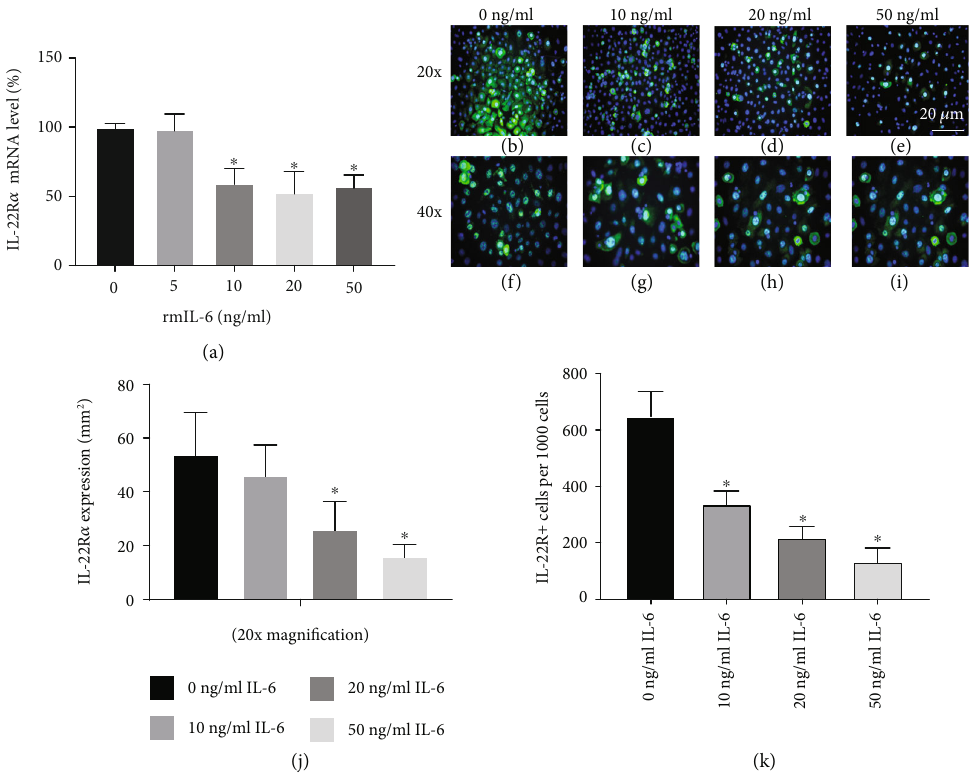
Figure 3: IL-6 negatively regulates IL-22R α expression on epidermal keratinocytes. Primary keratinocytes from IL-6KO mice were treated with rmIL-6 for 4/24 hours (mRNA/protein expression) at the indicated concentrations. The expression of IL-22R α mRNA was analyzed and normalized to 28S ribosomal RNA as control (a). IL-6KO keratinocytes were grown to con fl uency on multichamber slides. Immunohistochemical analysis of keratinocyte culture stained for the expression of IL-22R α (green), and nuclear staining DAPI (blue). Representative fl uorescent images are shown at 20x (b – e) and 40x (f – i). Quanti fi cation of IL-22R α expression as determined by ImageJ (NIH) is presented (j and k). Data are mean ± SD . ∗ Signi fi cantly di ff erent from 0 ng/ml rmIL-6 ( p ≤ 0 : 05 , n = 3 separate